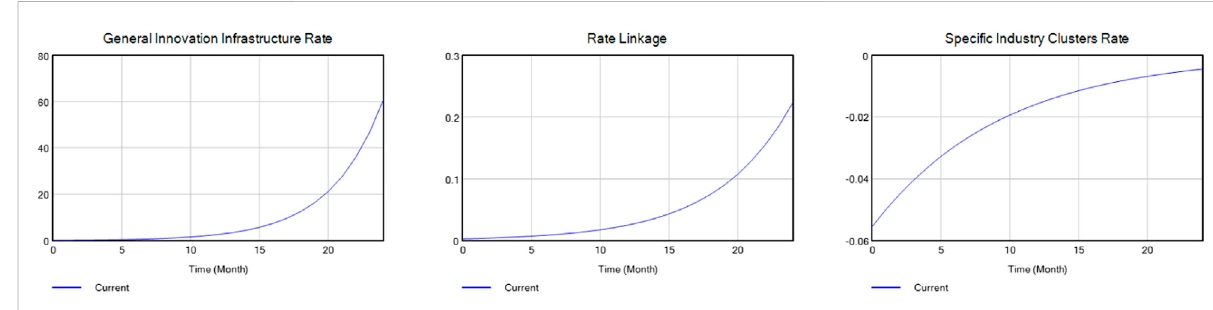
FIGURE 9 Existing condition of simulation result source: Data processing results, 2022.